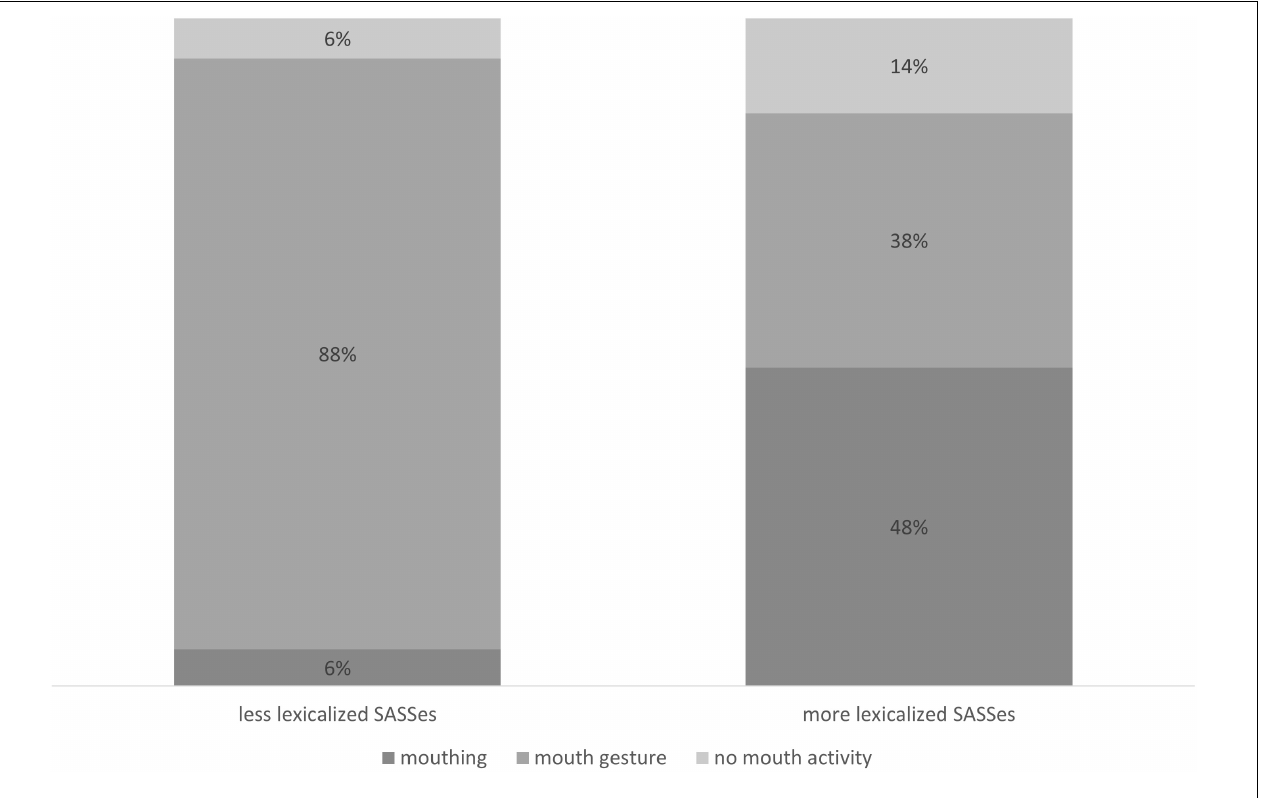
FIGURE 9 | Distribution of non-manual activity types in less-lexicalized versus more-lexicalized